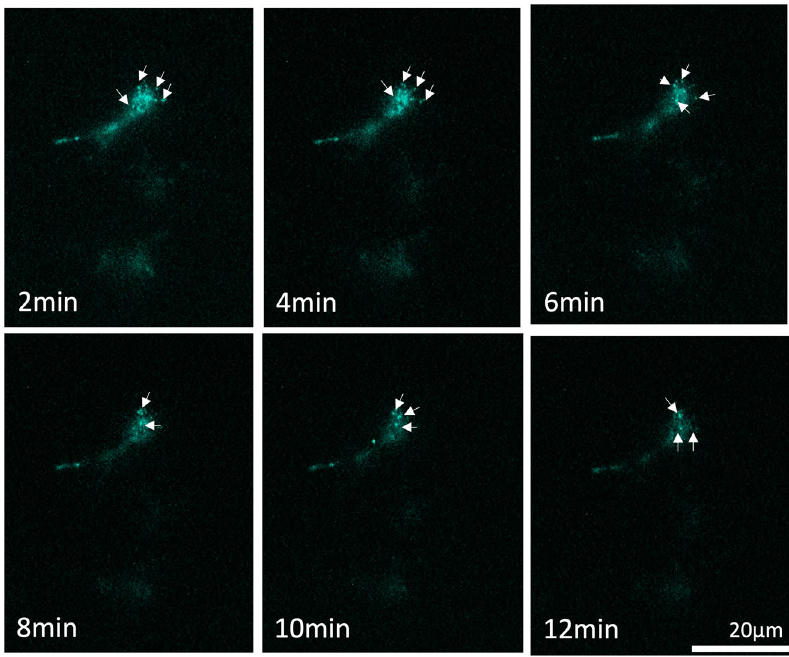
Fig. 4 Visualization of receptor localization in HEK293 cells using a bioluminescence LV200 Olympus microscope. HEK293 cells were transfected with β 2AR-SmBiT and LgBiT-FYVE. The luminescence images were acquired after the addition of the luciferase substrate, furimazine, and 10 µ M epinephrine ( fi nal concentration) by capturing total luminescence for 2 min at each of the indicated times. Scale bar represents 20 µ m.